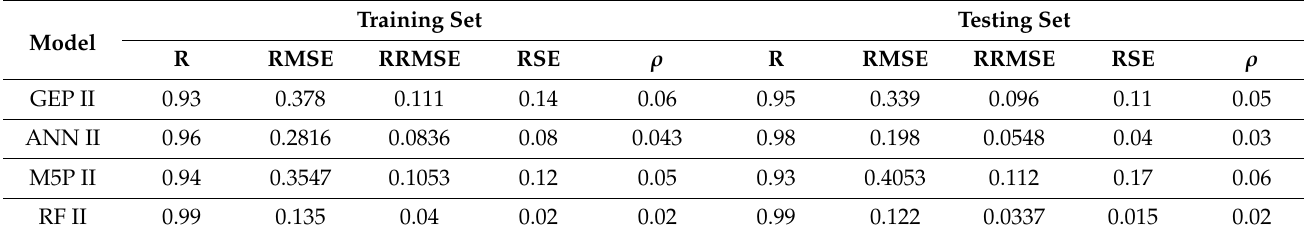
Figure 16. Experimental and predicted values of f st by RF II for ( a ) training set and ( b ) testing set, and their corresponding absolute error for ( c ) training data set and ( d ) testing data set. Table 6. Statistical evaluation of GEP II, ANN II, M5P II, and RF